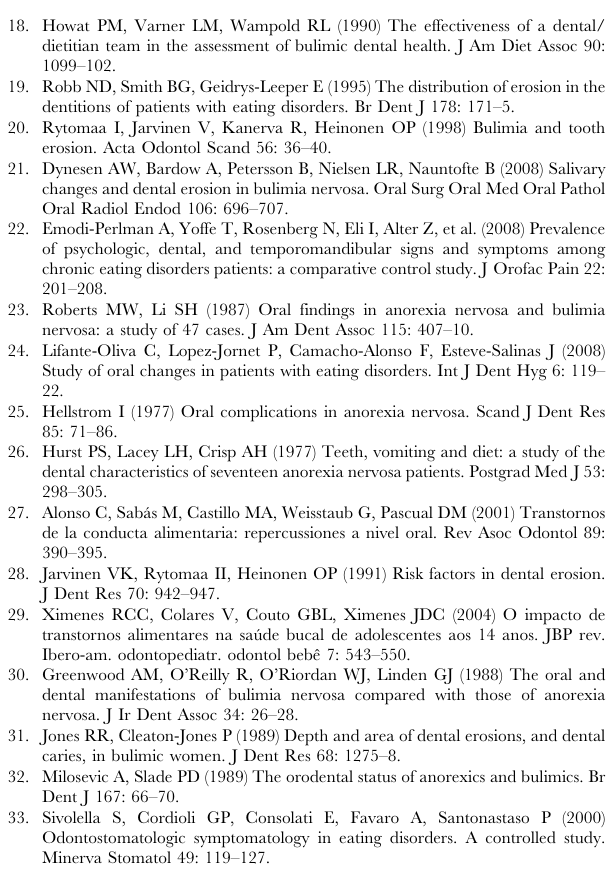
Table S1 List of titles selected for full text analysis